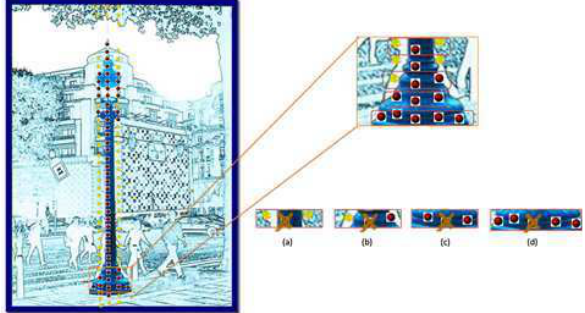
Fig. 10. Illustration of the uncertainty in the selection of the point representing the "lamppost". (a) Case of a selection based on a single profile φ = 0. (b) Case of a selection based on two profiles φ = 0.25. (c) Case selection based on three profiles: φ = 0.5. (d) Cases selected on the basis of four profiles: φ = 0.75. (e) Provision for selection on the basis of five profiles φ = 1.